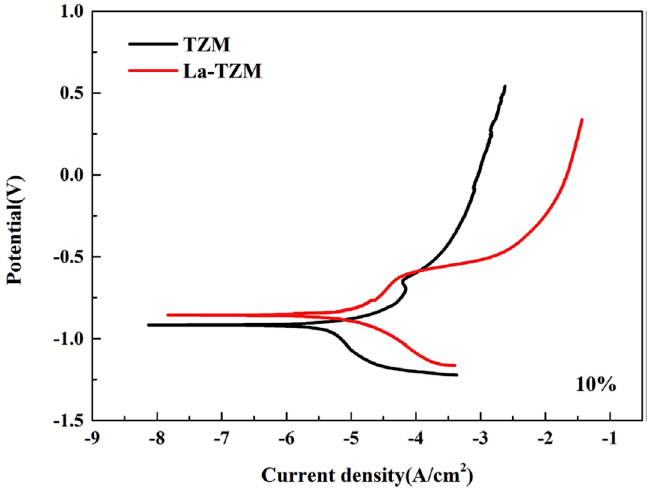
Figure 8. Potentiodynamic polarization curves of TZM and La-TZM alloys [98].